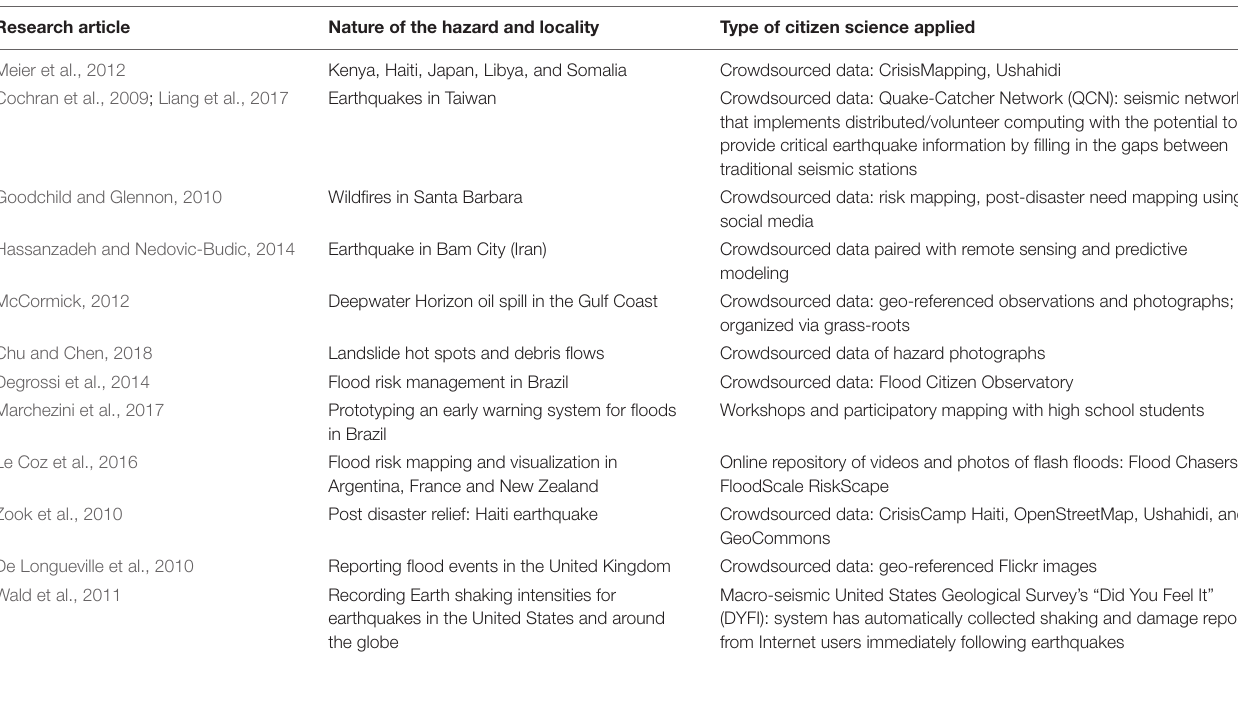
TABLE 1 | Example of citizen science use in disaster